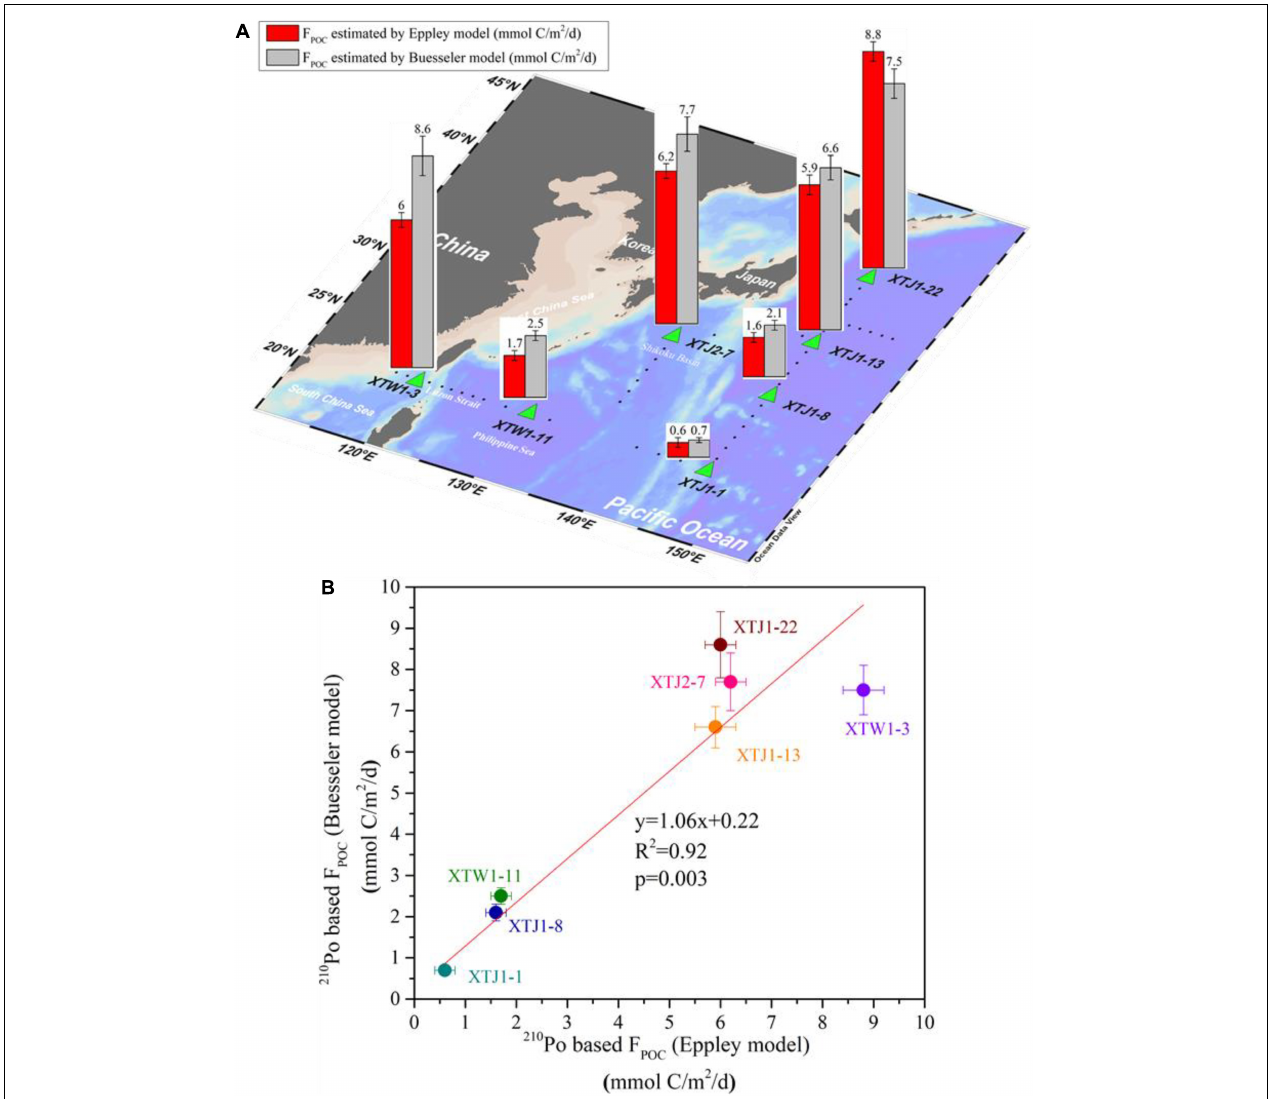
FIGURE 9 | (A) Spatial distribution of POC export fluxes derived from 210 Po for the upper w-NPO. (B) Relation between the Eppley and Buesseler model-calculated POC export